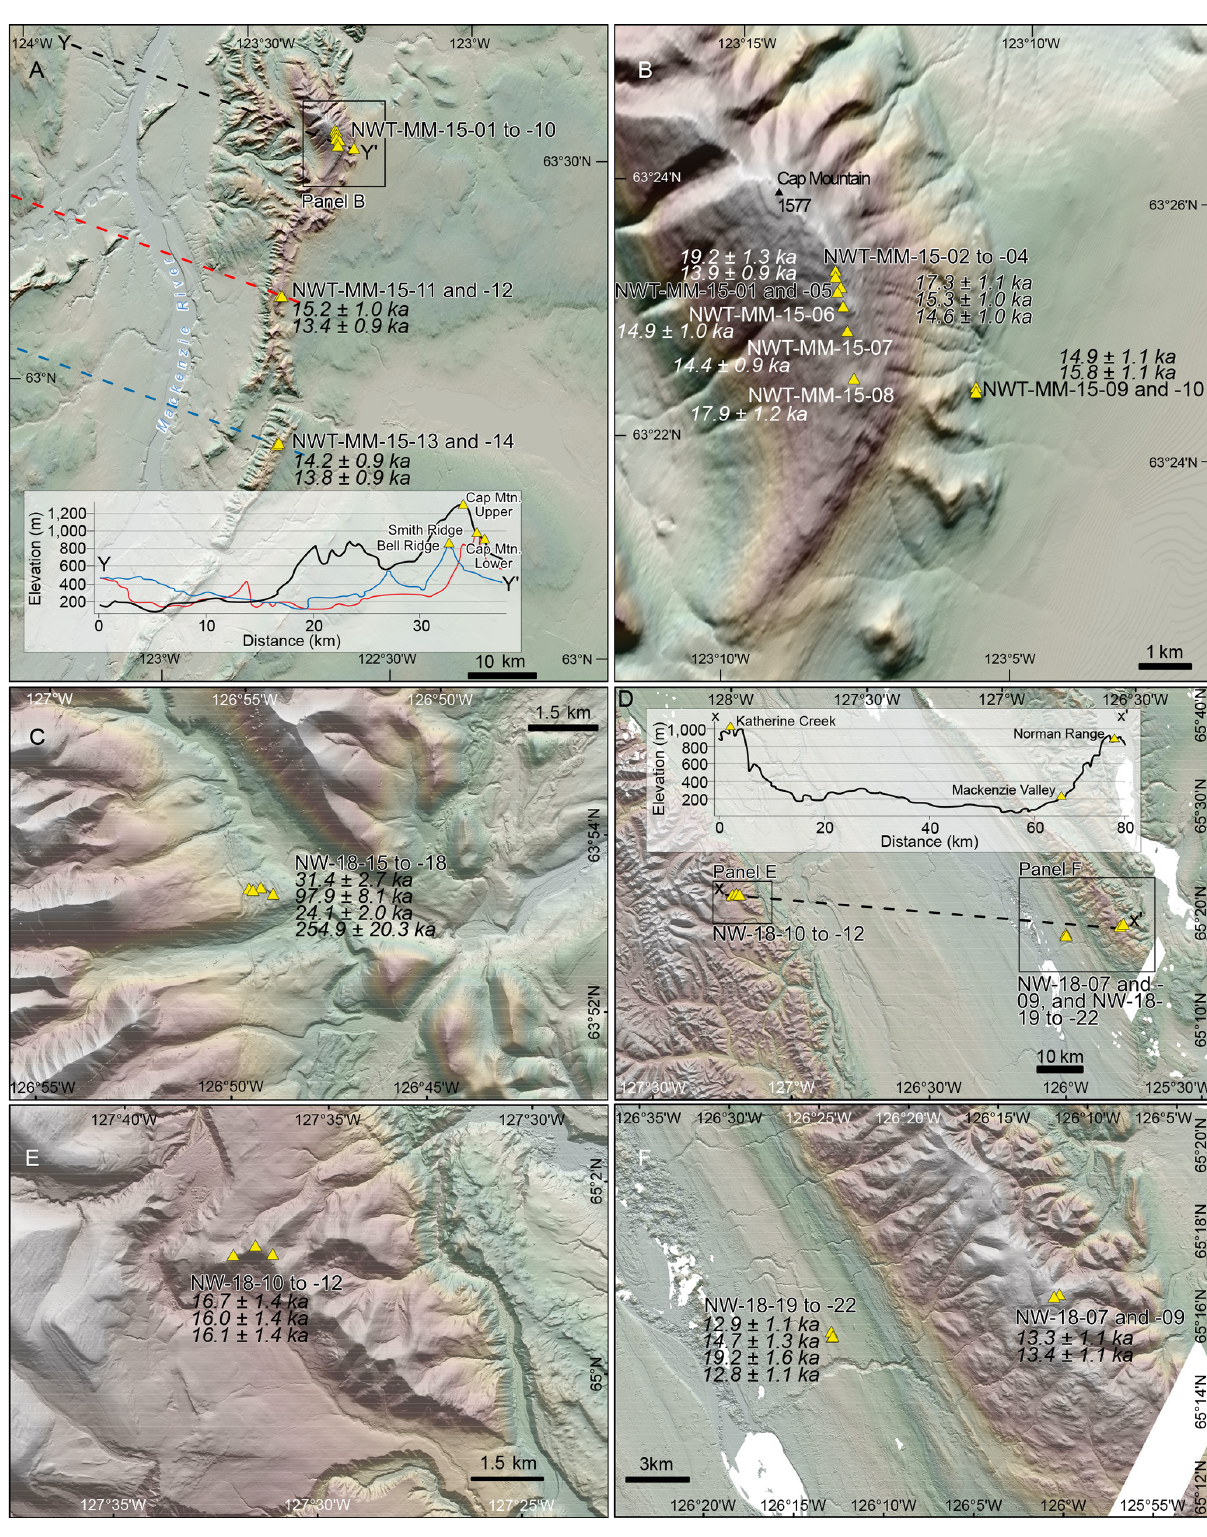
Figure 3. (a) Location of the sampling sites in the Franklin Mountains. (b) Close-up of Cap Mountain, where samples NWT-MM-01 to 10 were collected along an elevation transect. (c) Close-up of the Dark Rock Creek site. (d) Location of the northern sampling sites. (e) Close- up of the Katherine Creek site, where samples NWT-18-10 to 12 were collected along the ridge. (f) Close-up of the Mackenzie Valley and Norman Range sites, where samples NWT-18-19 to 22 and samples NWT-18-07 to 09 were collected. Digital elevation model (DEM) courtesy of the Polar Geospatial Center (Porter et al.,